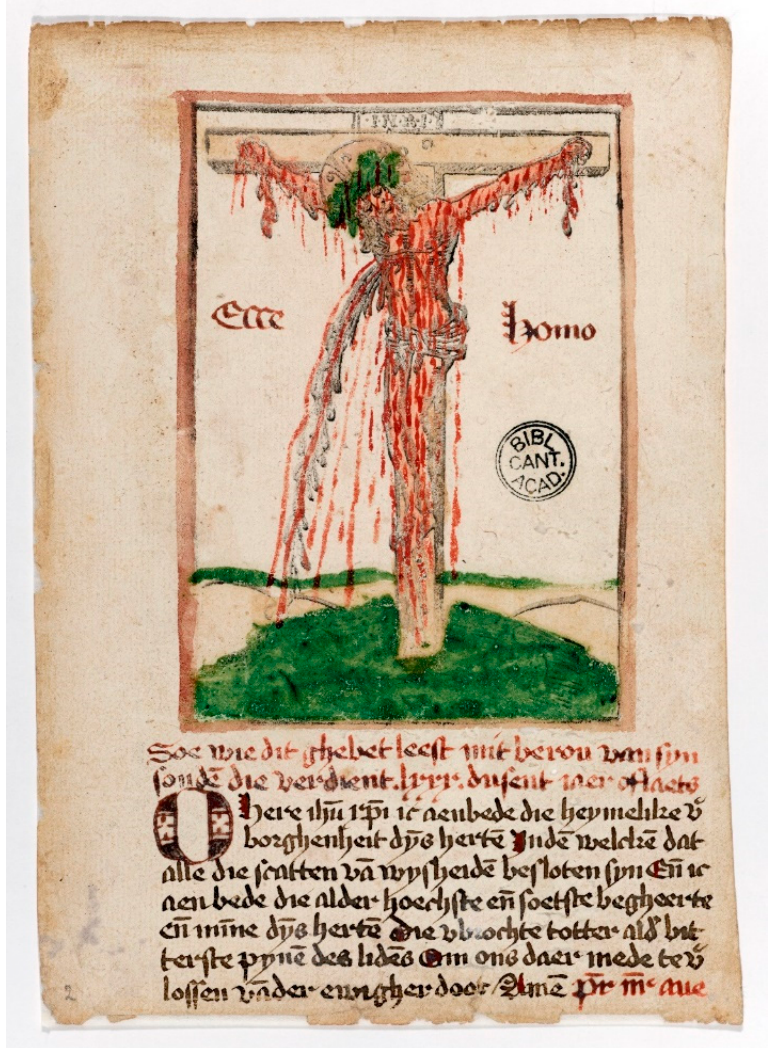
Figure 35. Cambridge University Library MS Additional 5944(11), c.1450. Reproduced by kind permission of the Syndics of Cambridge University Library.